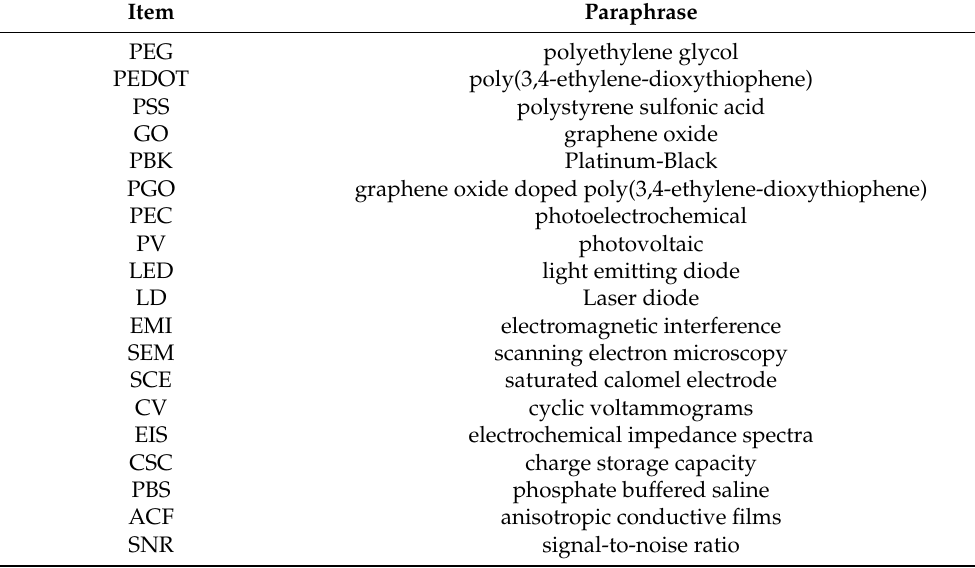
Table 1. The dictionary of